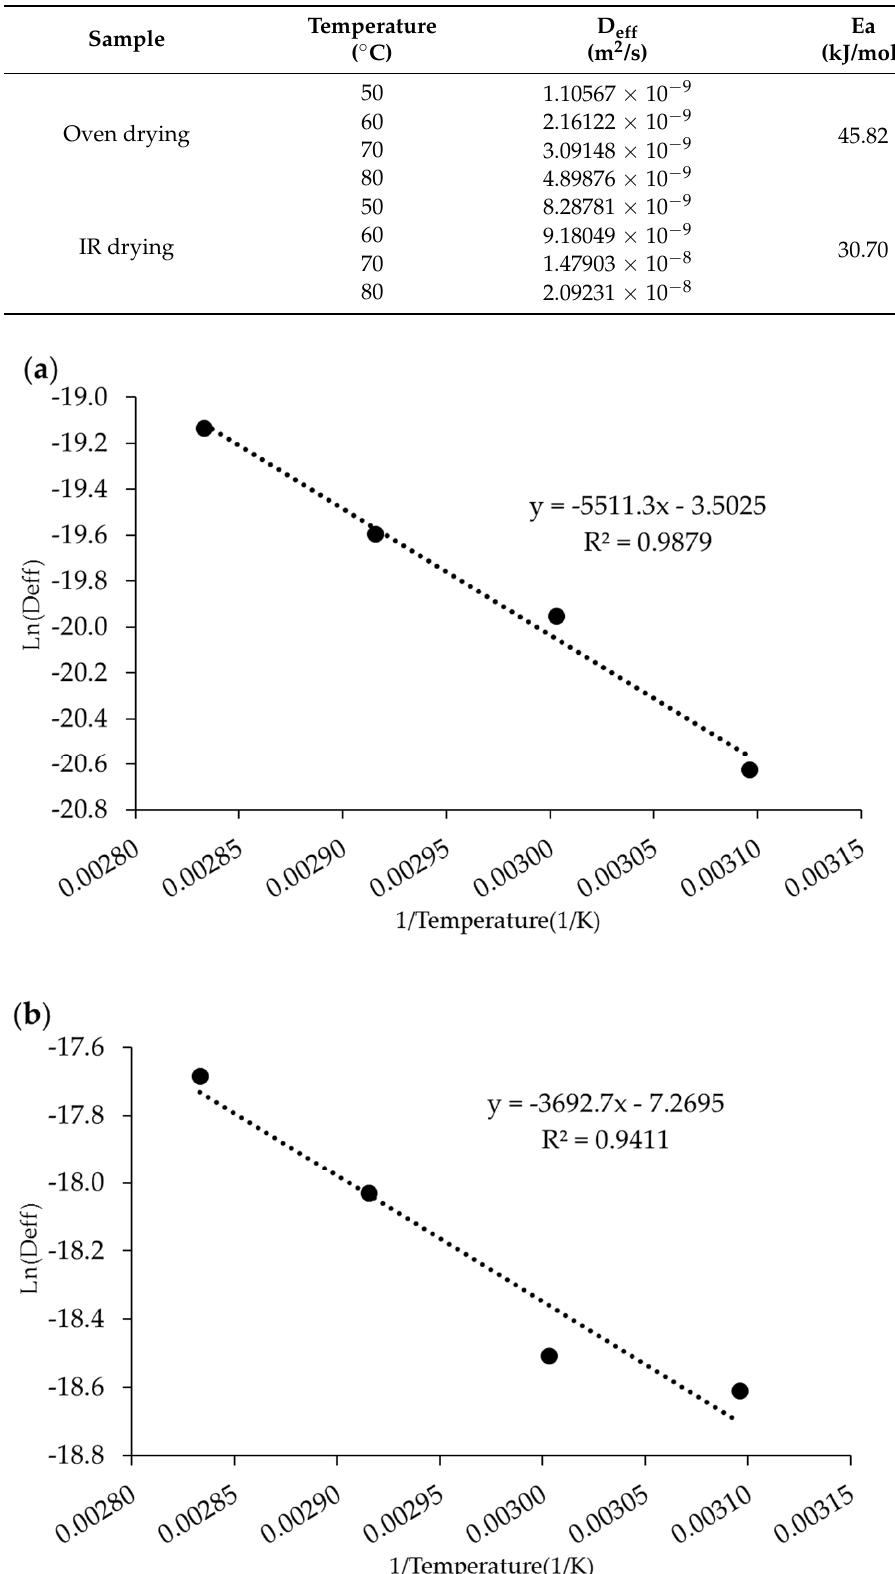
Figure 4. Relationship plot between ln(D eff ) versus reciprocal drying temperature for ( a ) oven drying and ( b ) IR drying .